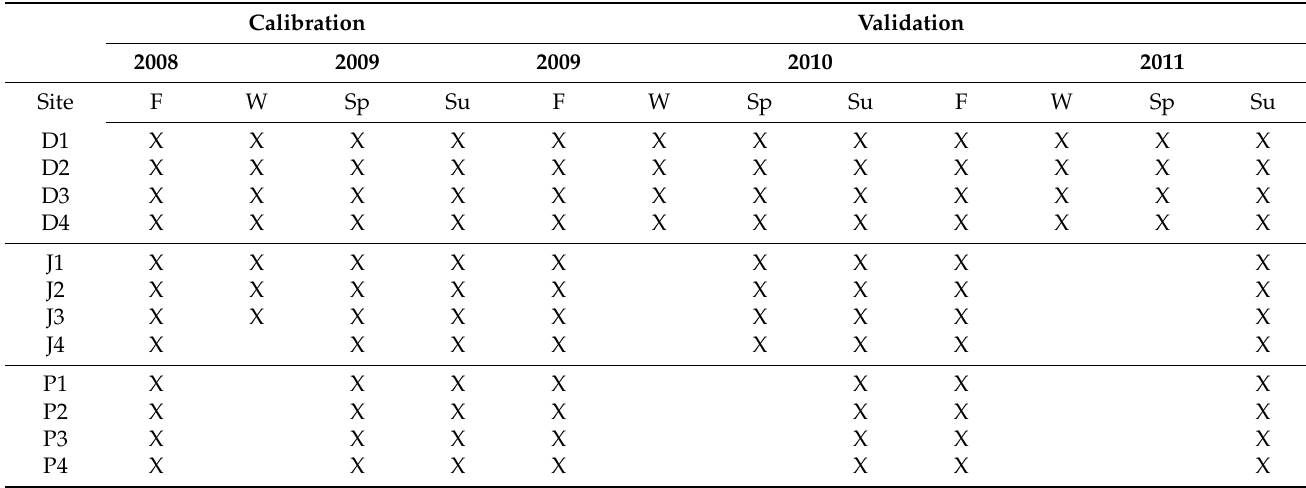
Table 1. Data sites and sampling frequency. An “X” denotes that the site was sampled that quarter; where “F” = fall, “W” = winter, “Sp” = spring, and “Su” = summer. Juniper and pine sites were at higher elevations and were not always accessible due to environmental